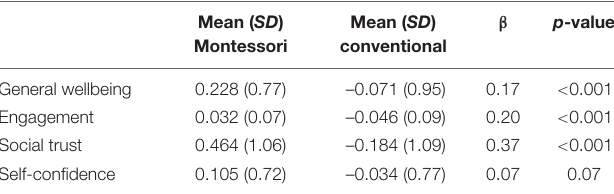
TABLE 7 | Analysis 2, private-only sample: means, SDs, standardized regression coefficients and p -values for SEM.